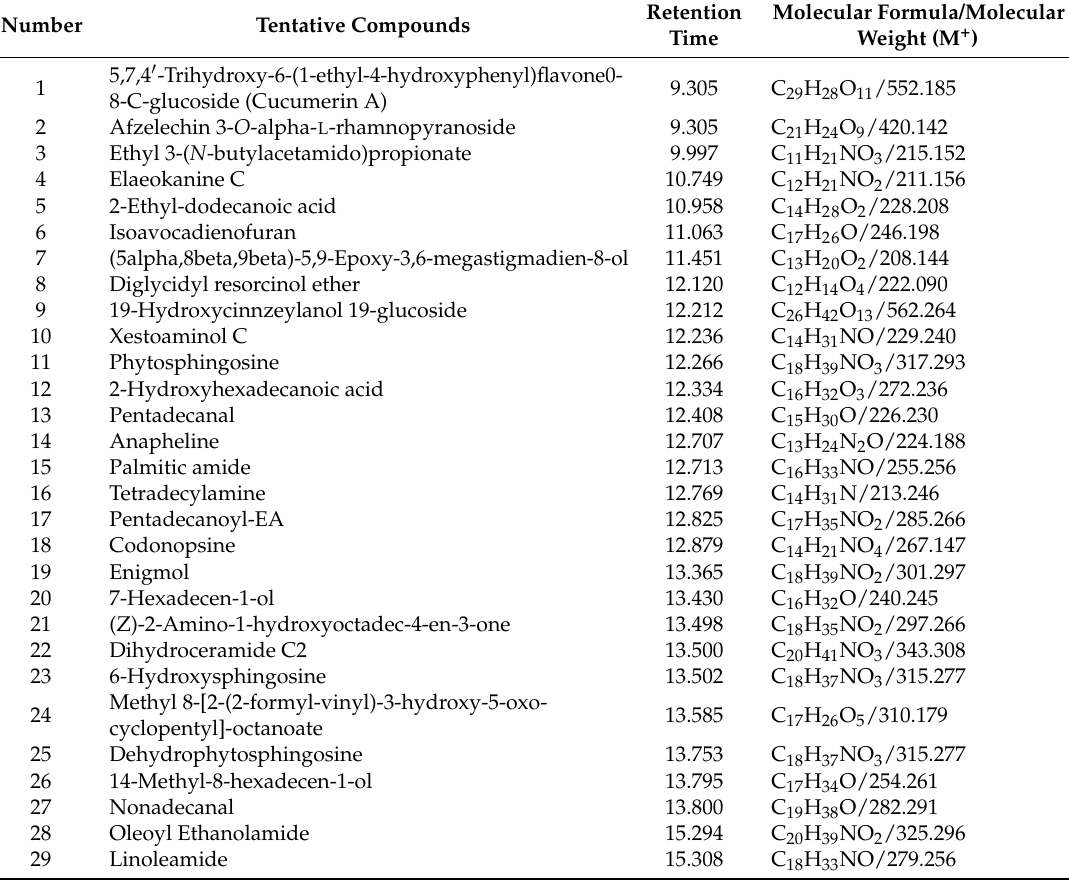
Figure 1. LC-MS spectrum of n-butanol fraction of Averrhoa bilimbi crude methanolic leaves extract (For compounds and retention time, please refer to Table 4). Table 4. Results of LC - QTOF - MS analysis of n-butanol fraction.